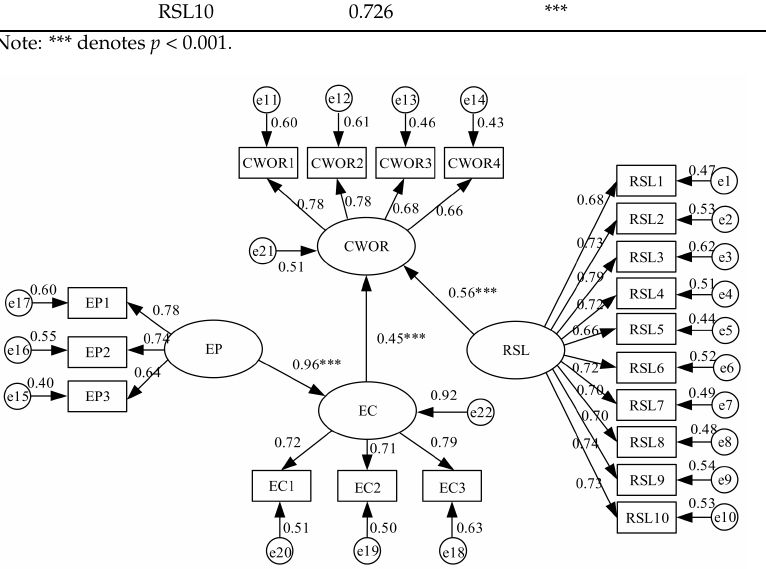
Figure 8. Results. (Note: *** p <